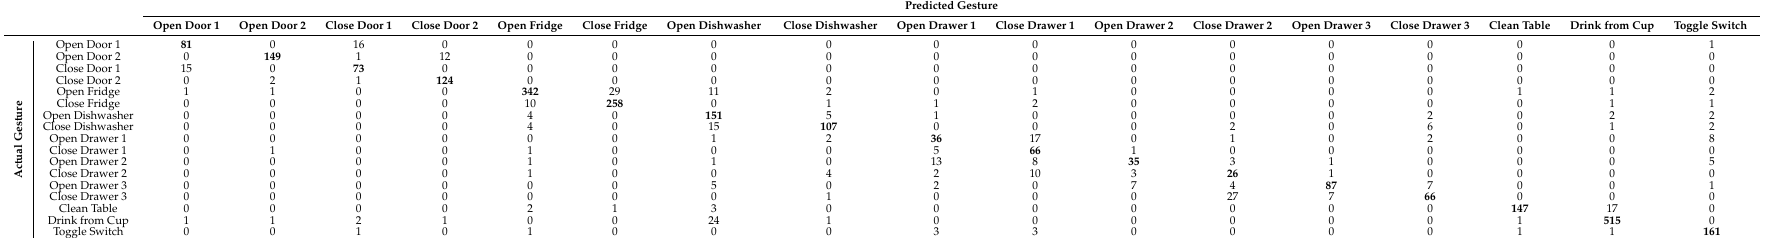
Table 7. Confusion matrix for OPPORTUNITY dataset using DeepConvLSTM (without the Null class).